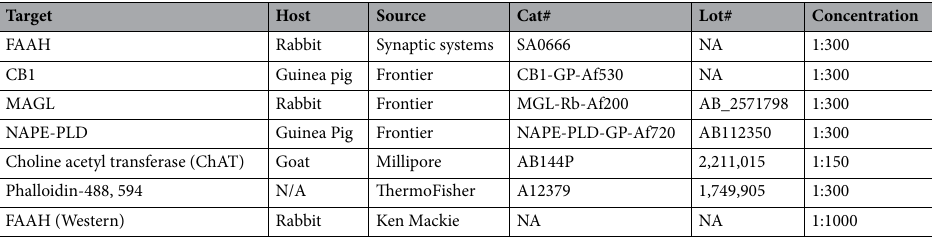
Table 1. Antibodies/primary labels used in this